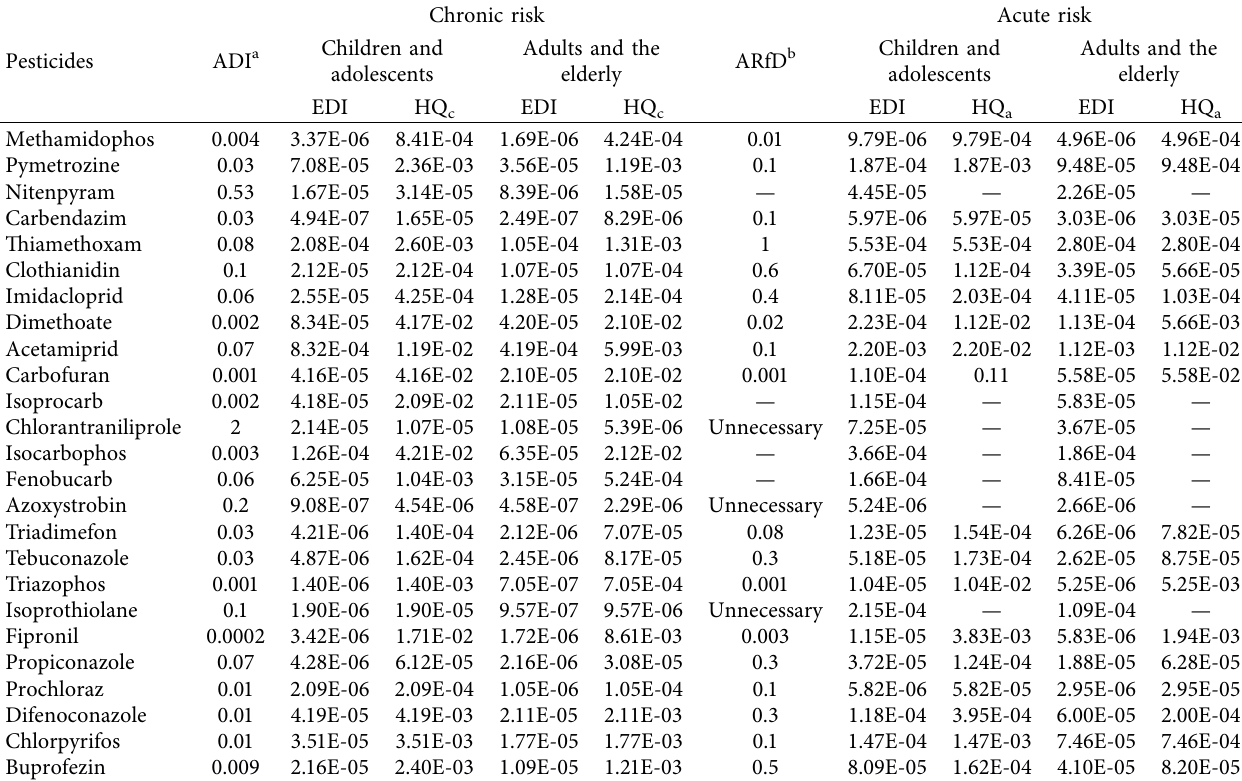
Table 5: Chronic and acute dietary exposure risk assessments of pesticide residues (mg/kg bw/day) in brown rice. Pesticides ADI a